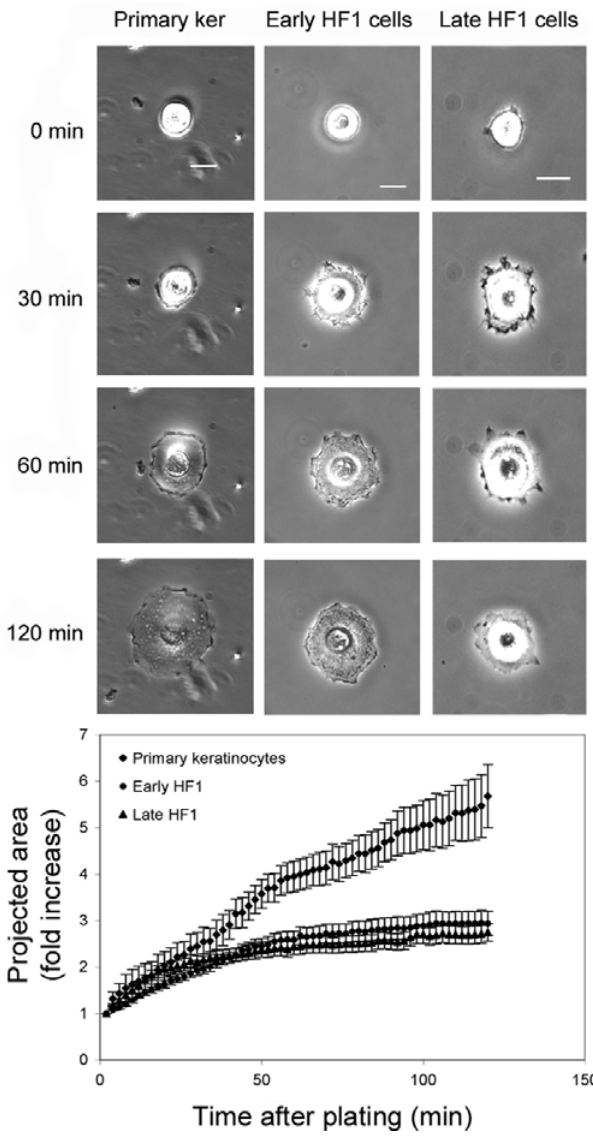
Figure 4. Cell spreading in the primary keratinocytes, early HF1 and late HF1 cells. Cell spreading movies were created by acquiring live-cell images every minute throughout 2 h of the experiment. A. Images show a representative cell in 4 time-points along the experiment, in the beginning (0 min), after 30 min, 60 min, and 120 min of the experiment. B. Graph shows quantification of cell area along the experiment. To quantify cell spreading, polygons, defining the cell perimeter were manually marked, at different time points, and the projected cell area was calculated by an application within the UCSF PRIISM environment (http://msg.ucsf.edu/ive). Error bars represent standard errors of . 30 cells examined in 3 independent experiments.